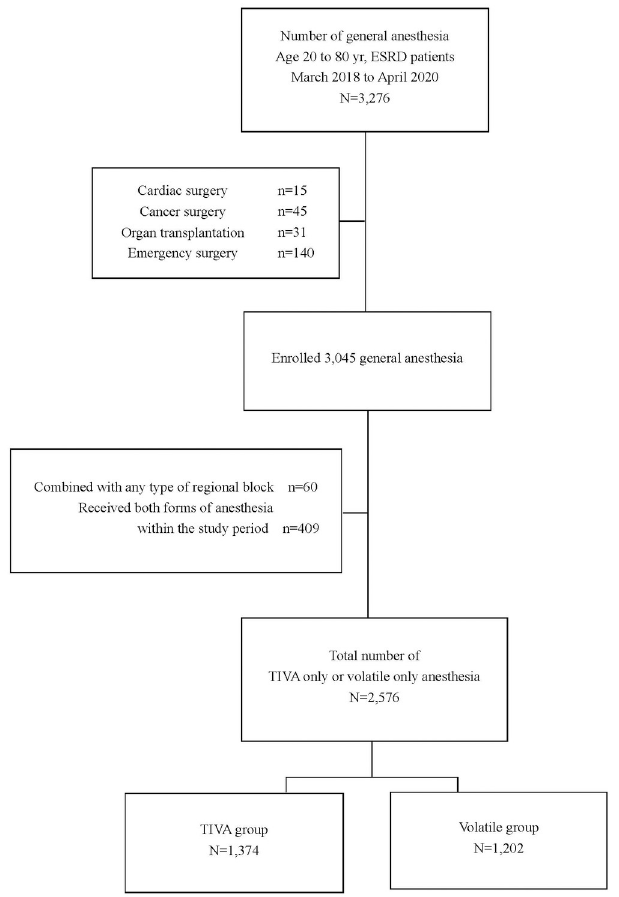
Fig 1. Study flow chart. TIVA group, patients who received only propofol-based total intravenous anesthesia; Volatile group, patients who received only volatile anesthesia.